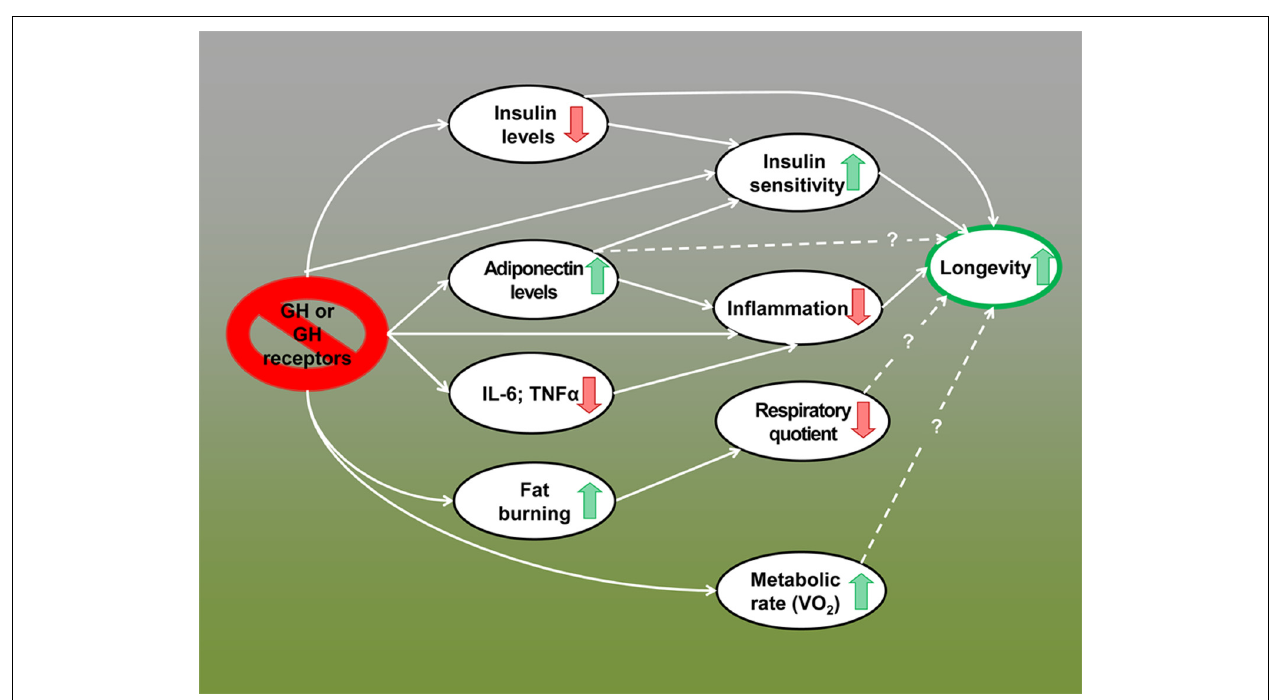
FIGURE 1 | Metabolic alterations in GH-deficient and GH-resistant mice; possible mechanisms of extended